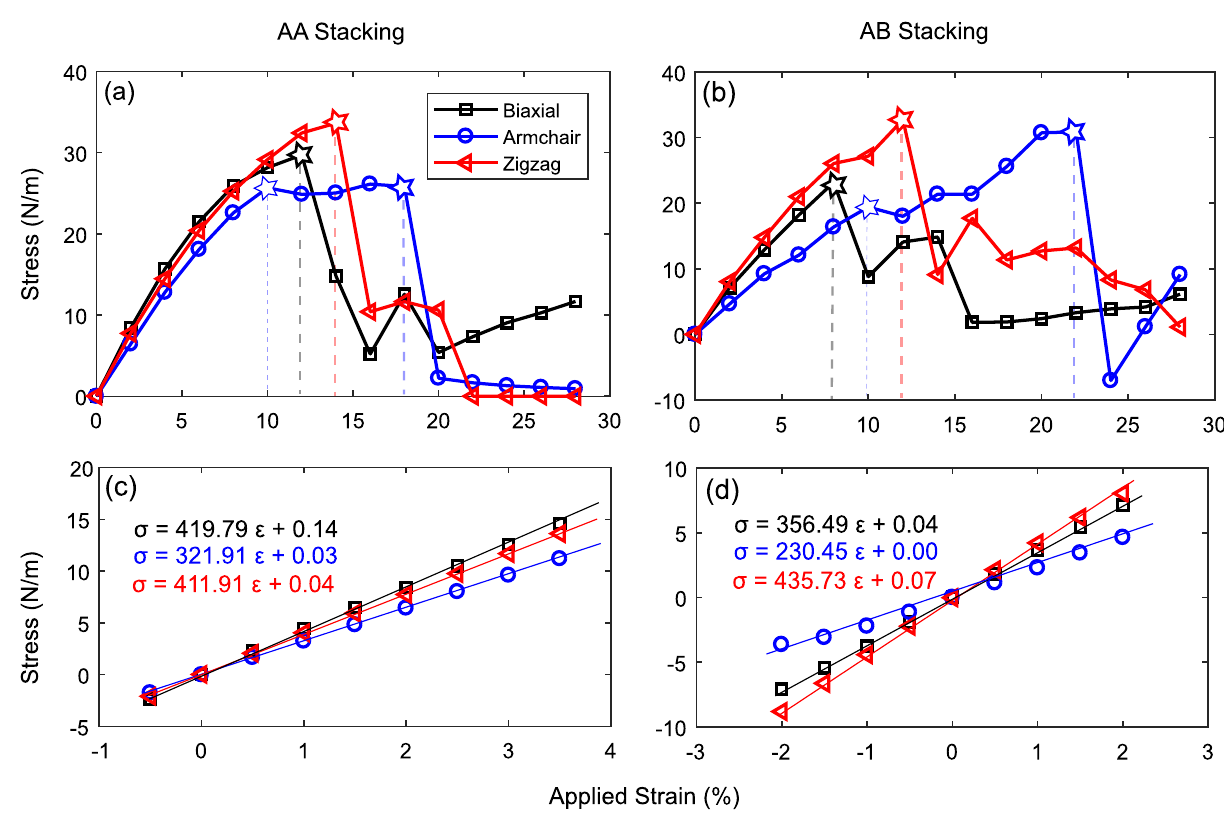
Figure 7. Mechanical properties of β 12 borophene with AA and AB stacking. ( a, b ) Long-range stress-strain curves used to find the critical strains and ultimate strengths. ( c, d ) Short-range stress-strain curves in the harmonic range used to calculate Young’s